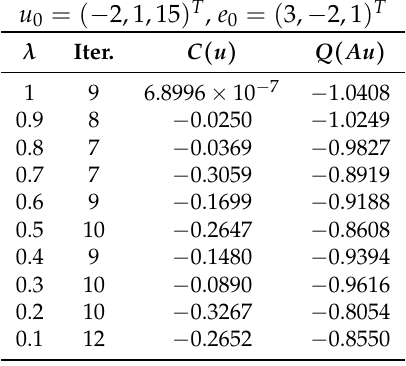
Table 4. Numerical results for solving Example 2 with different λ